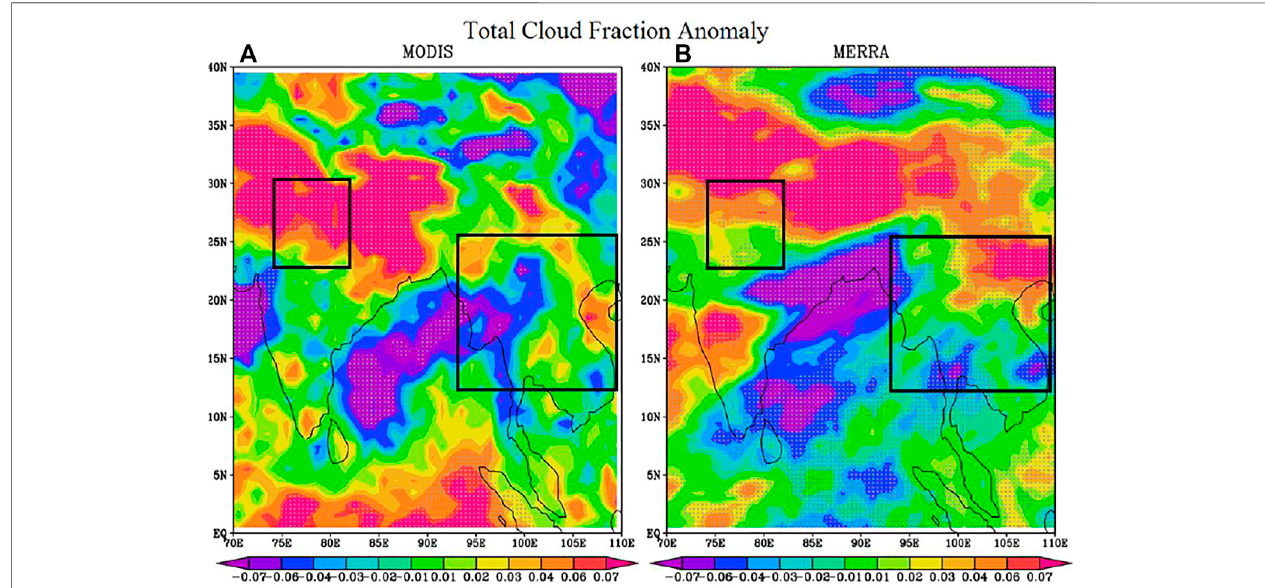
FIGURE 5 | Total cloud fraction anomaly (2020-climatology) from MODIS and MERRA for the lockdown period of April-May. White dots in (A,B) indicate a 99% signi fi cance level. Boxes in (A,B) indicate North India and Myanmar regions.